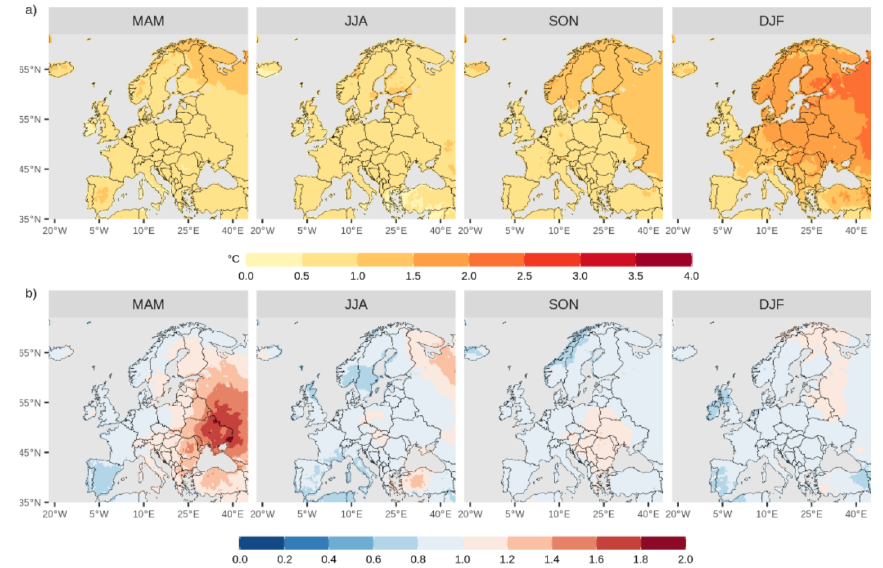
Figure 8. Spatial distribution of ( a ) MAE and ( b ) SPR for calibrated ECMWF SEAS5 ensemble seasonal forecasts of 2-m mean air temperature (one-month lead time) over Europe (land only) with respect to ERA5 reanalysis over 1993–2016.